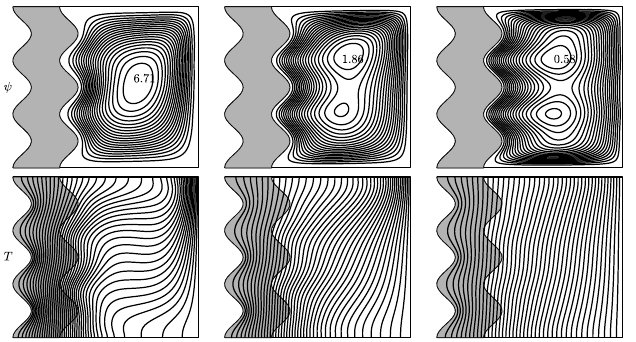
Figure 4. Variation in Ha when Ra = 10 5 , kr = 1, γ = 0 ◦ , A = 0.05, n = 3. Streamlines and isotherms at the ( top ) is for case 1, at the ( middle ) is for case 2 and the at ( bottom ) is for case 3.